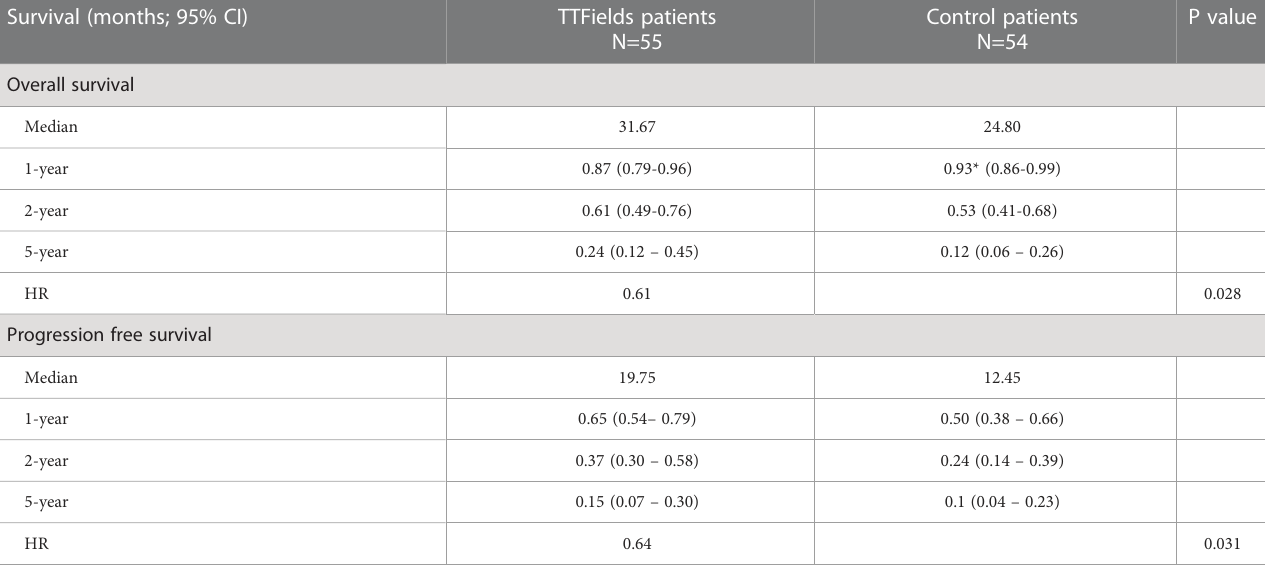
TABLE 2 Survival data. Survival (months; 95% CI)